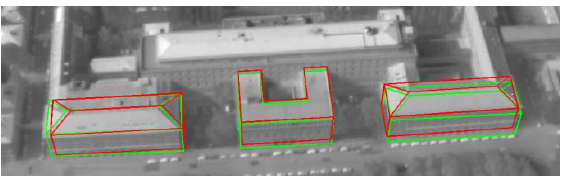
Figure 5. Projected model before adjustment (green) and after adjustment